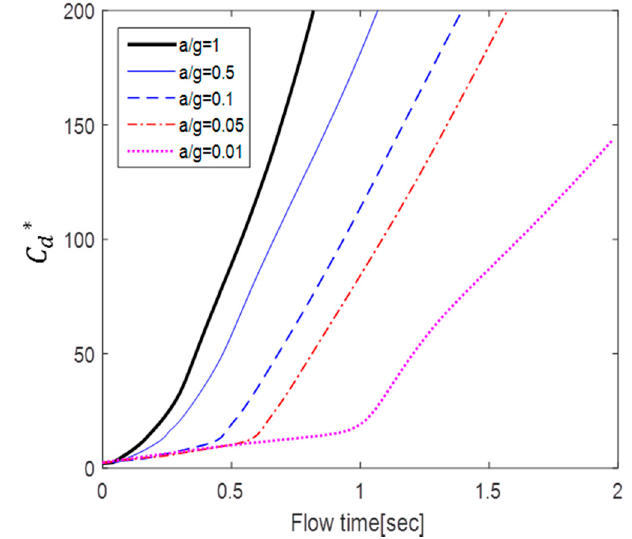
Figure 12. Temporal variation of drag coe ffi cient C d ∗ ( Re 0 = 40 )